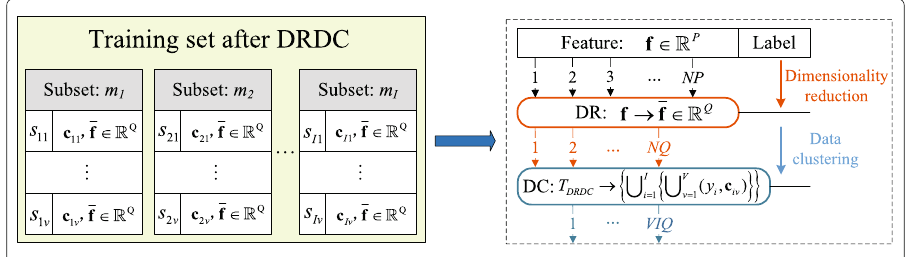
Fig. 8 Training set architecture for the DRDC-A- k NN AMC